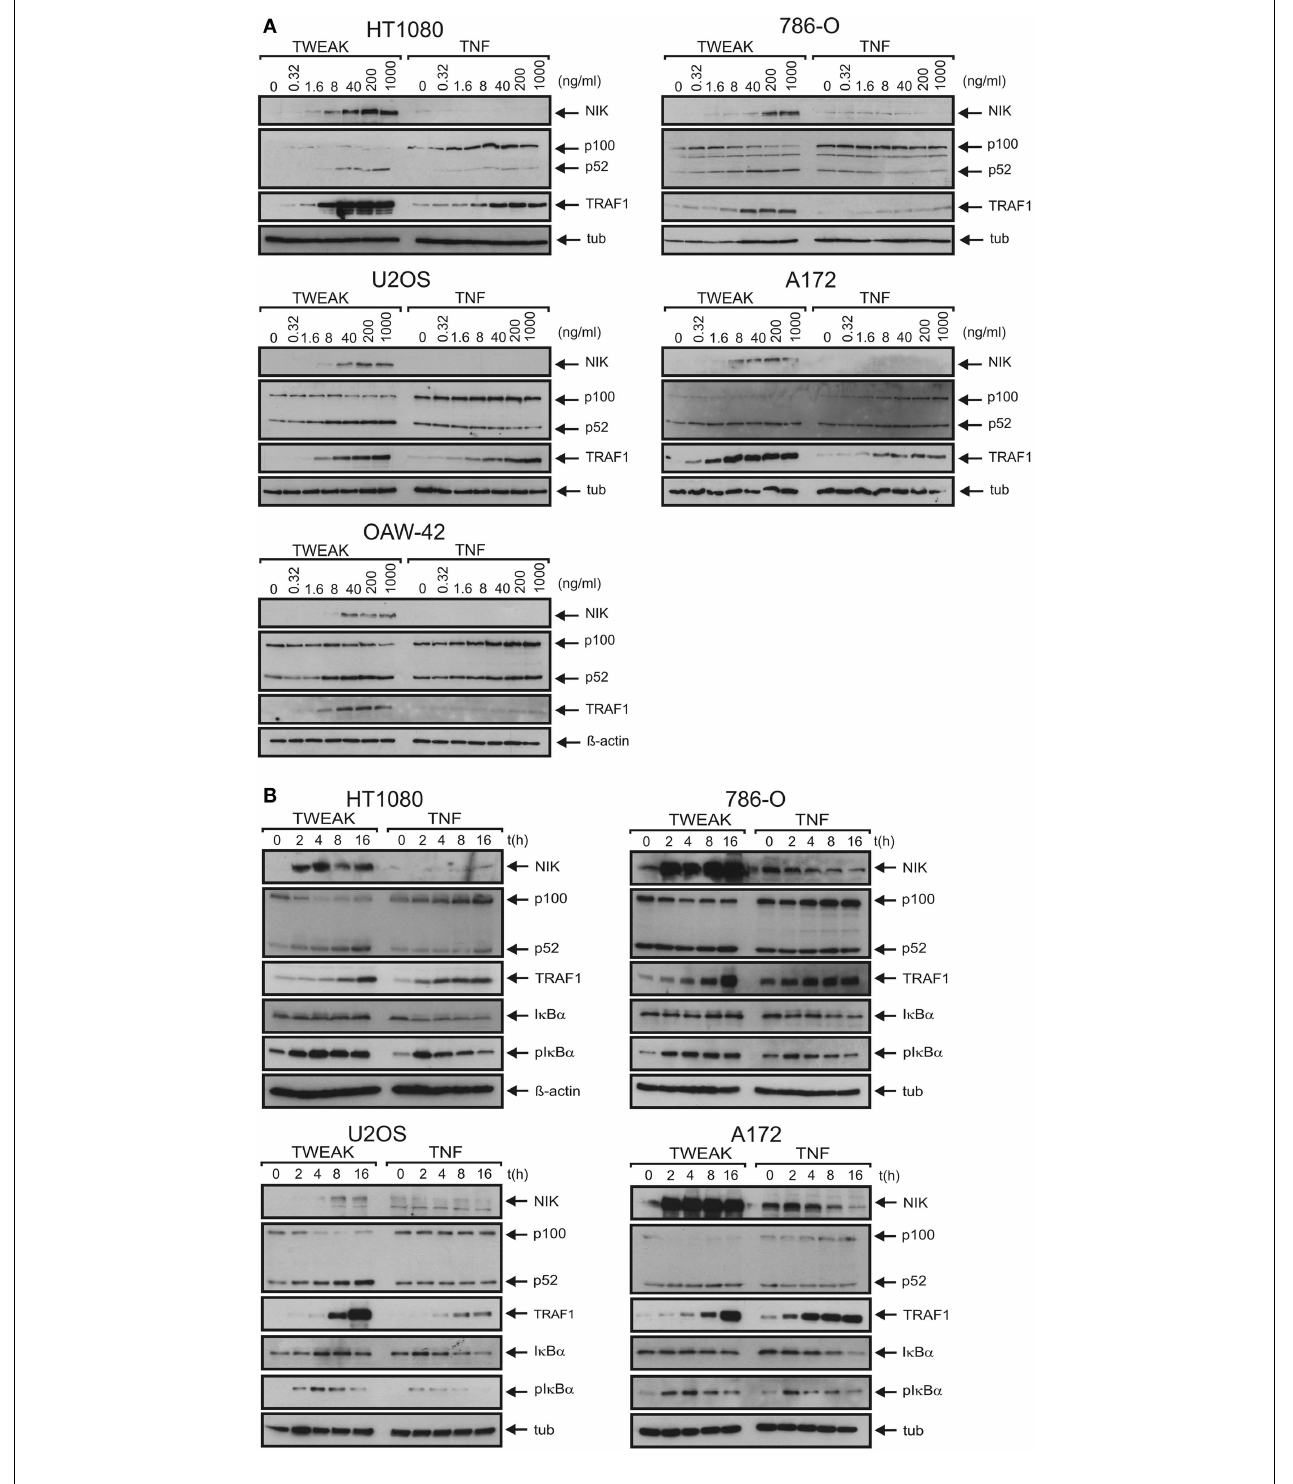
constant amount of these cytokines (100ng/ml Flag-TNF, 200ng/ml Flag-TWEAK) for varying times (B) .Total cell lysates were finally analyzed by western blotting with respect to the indicated